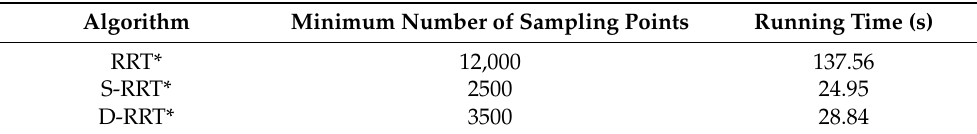
Table 4. Comparison of the three algorithms in path planning with different starting